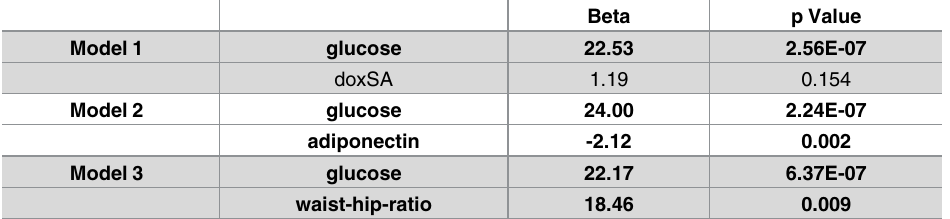
Table 5. Binary logistic regression models for incident T2DM, participants with a BMI (cid:21) 30 kg/m 2 (n = 199).